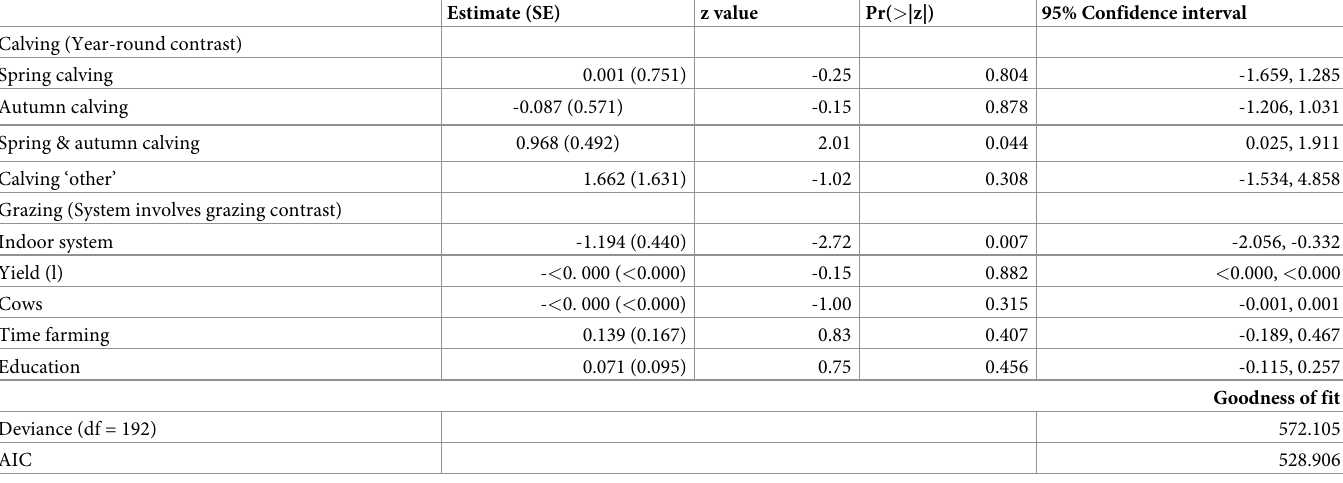
Table 4. ‘It’s easier to turn a profit on a pasture-based farm than an indoor farm’–ordinal model summary results. Estimate